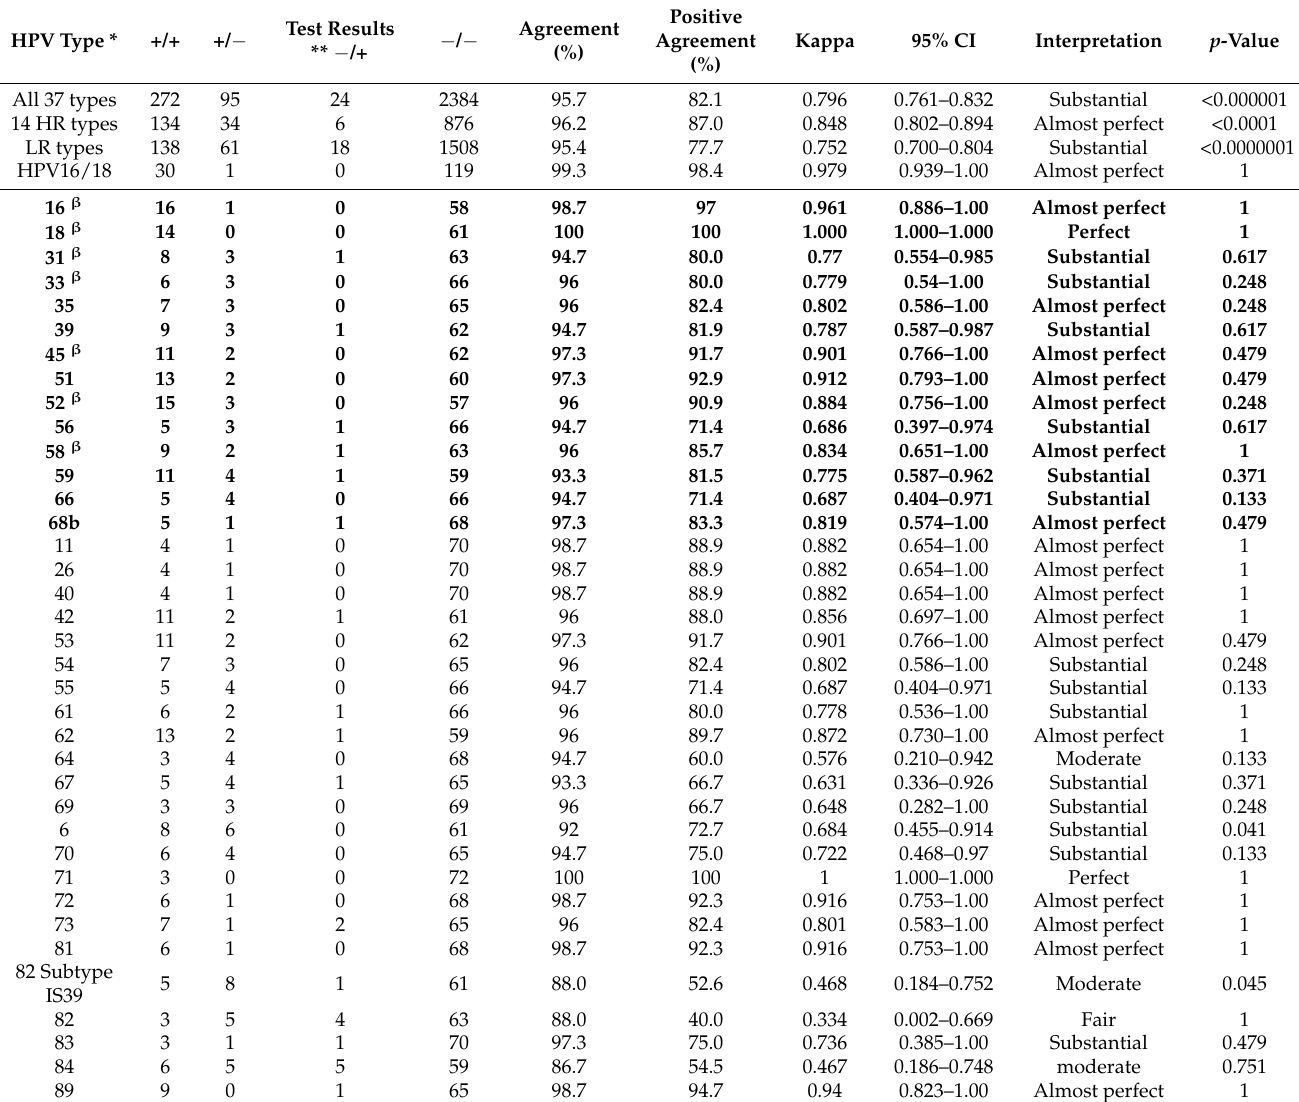
Table 3. HPV genotype-specific comparison between PCR-15 with